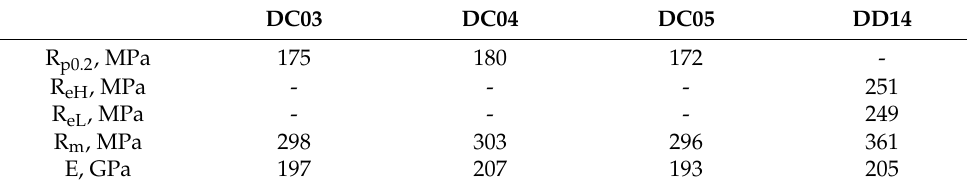
Table 4. The mechanical properties of the investigated steels determined in tensile tests. DC03 DC04 DC05 DD14 R p0.2 , MPa 175 180 172 - - - - 251